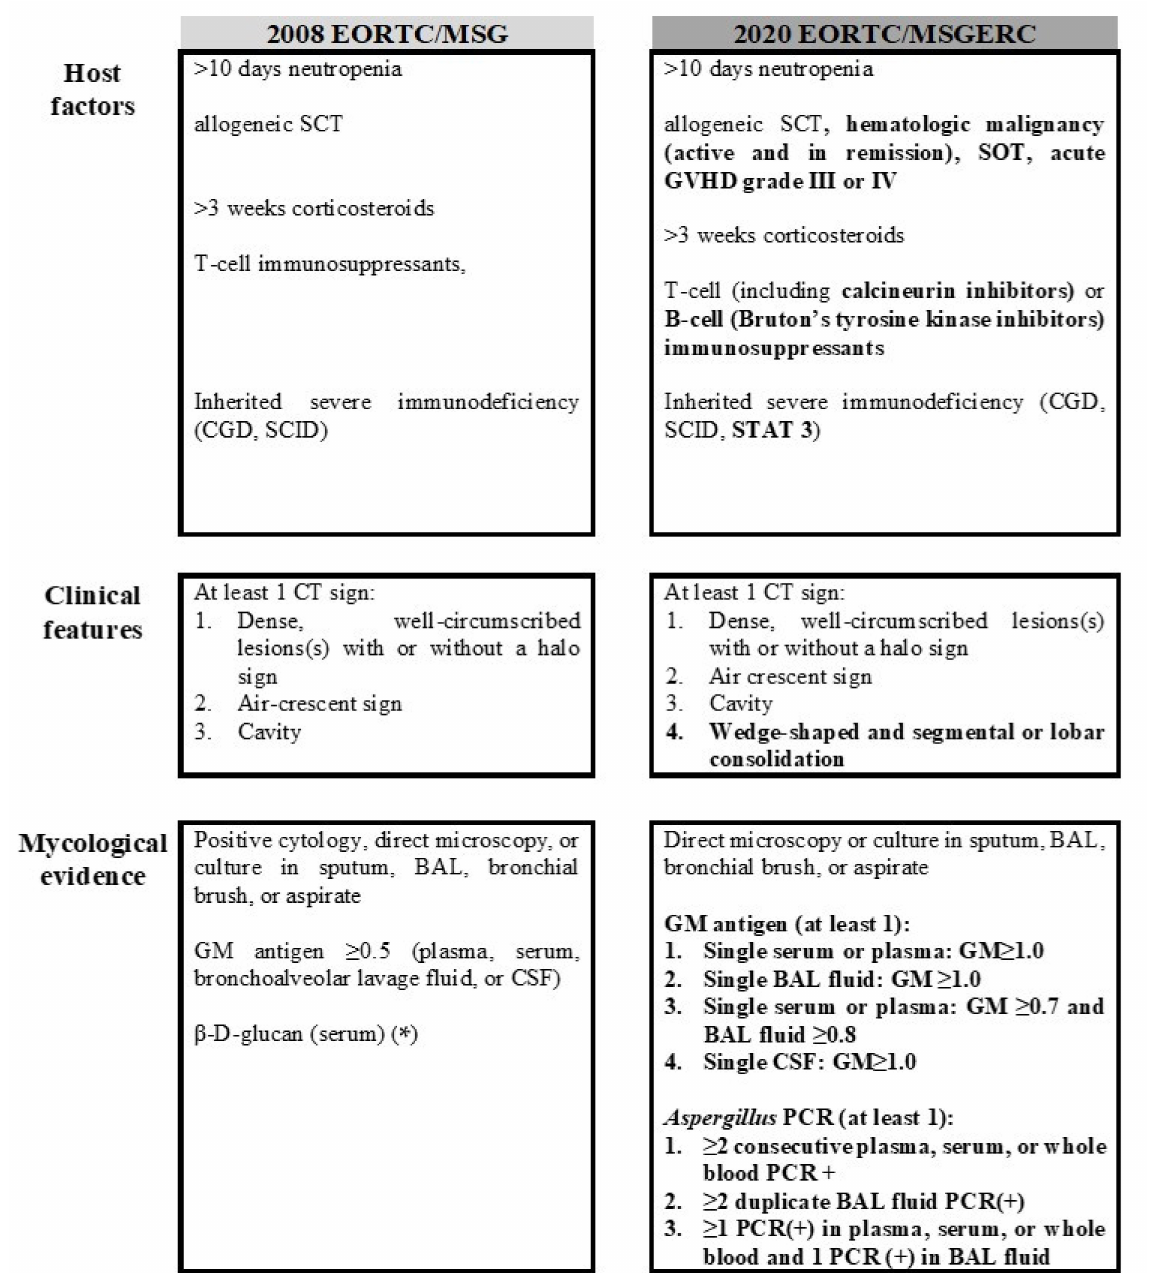
Figure 1. Criteria for probable invasive pulmonary aspergillosis according to the 2008 European Organization for Research and Treatment of Cancer-Invasive Fungal Infections Cooperative Group/National Institute of Allergy and Infectious Diseases Mycosis Study Group (EORTC/MSG) and the recently updated 2020 EORTC/MSGERC (revised conditions) definitions (differences between them are highlighted in bold). At least one host factor, a clinical feature and mycological evidence are required for probable invasive aspergillosis. Cases that meet the host and clinical criteria but not the mycological criterion are considered possible invasive fungal disease. SCT: stem cell transplantation, CGD: chronic granulomatous disease, SCID: Severe combined immunodeficiency, GVHD: graft versus host disease, CT: computer tomography, BAL: bronchoalveolar lavage fluid, GM: galactomannan, CSF: cerebrospinal fluid, PCR: polymerase chain reaction. (*) The β -D-glucan assay was included as a marker for probable invasive fungal diseases, because this test detects other species of fungi besides Aspergillus